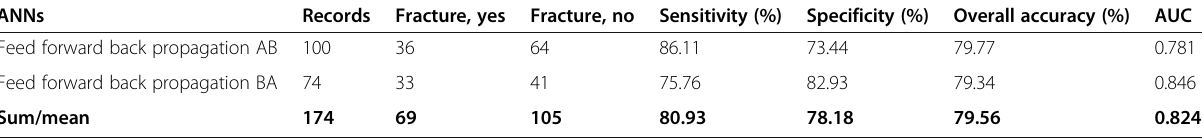
Table 2 Predictive results using artificial intelligence systems. The results refer to two testing experiments with training-testing A-B and B-A sequences